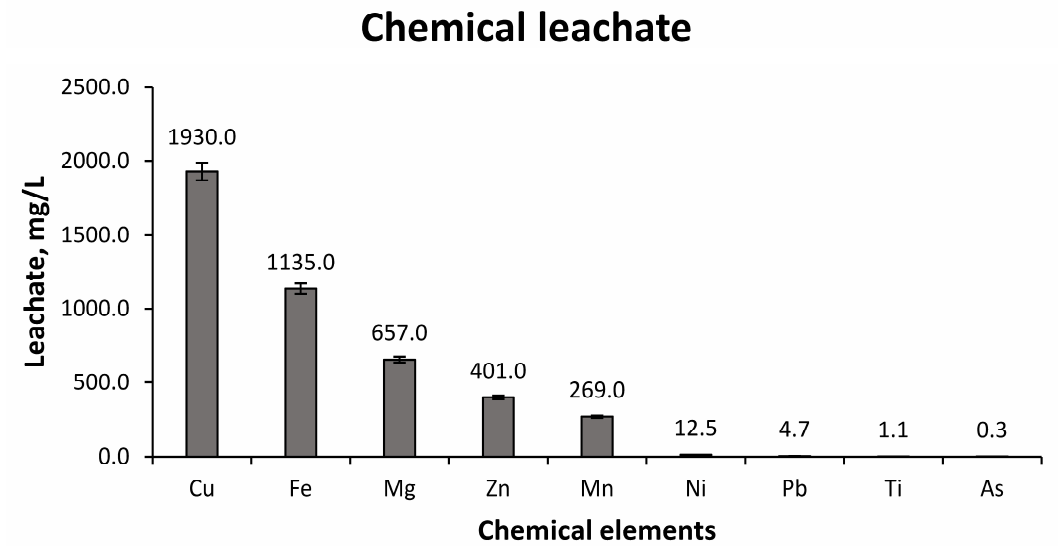
Figure 13. Comparison of the maximum concentration values of the different elements analyzed in the 0.20 molar Sulphuric Acid solution. Leaching process at ambient temperature and atmospheric pressure.